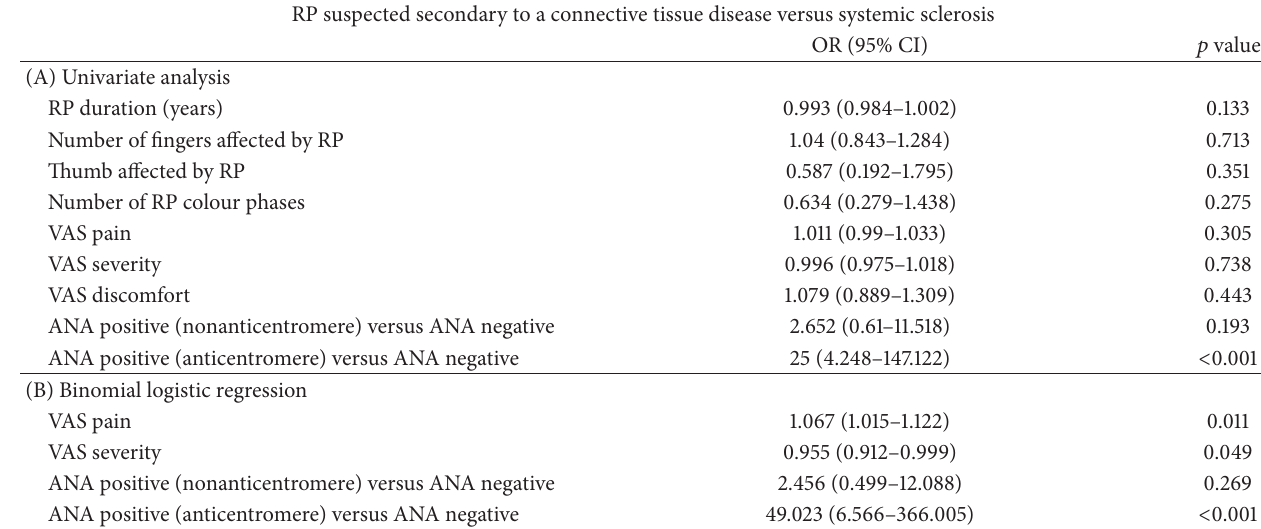
Table 3: Univariate analysis of Raynaud’s phenomenon secondary to a suspected connective tissue disease versus systemic sclerosis (A) and association of different variables assessed by binomial logistic regression